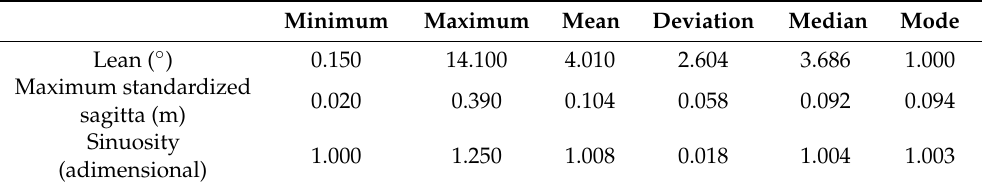
Table 2. Descriptive statistics of shape variables estimated from the TLS point